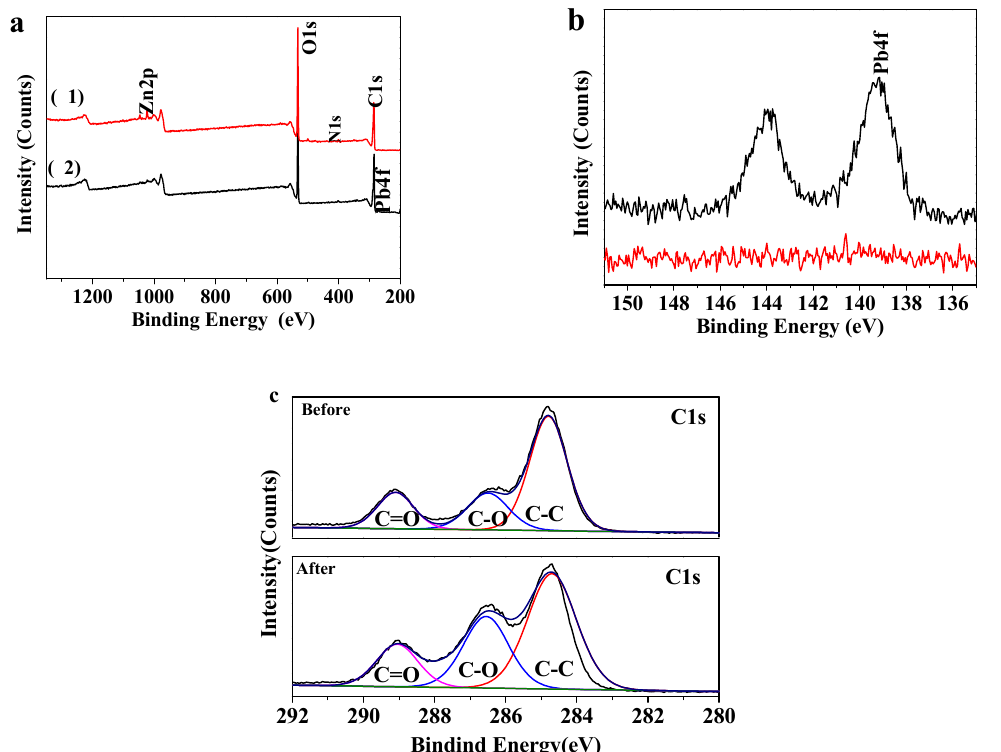
Figure 4. X-ray photoelectron spectroscopy (XPS) spectra of MOF-5–CMC: ( a ) survey spectra of (1) MOF-5–CMC and (2) Pb(II)-adsorbed MOF-5–CMC; ( b ) Pb 4f spectra of MOF-5–CMC before (lower) and after (upper) Pb(II) adsorption; C 1s spectra of MOF-5–CMC ( c ) before and after Pb(II)